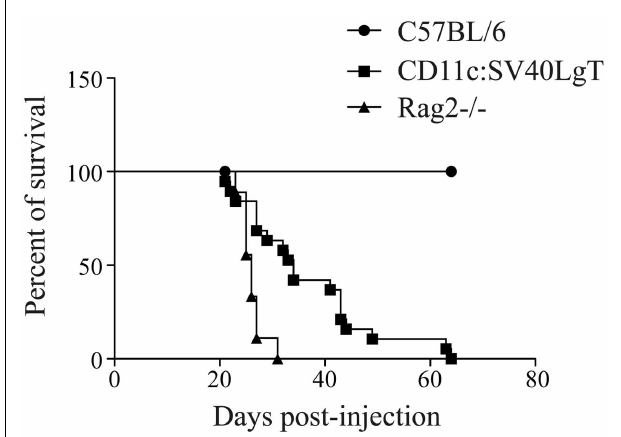
FIGURE 1 | MuTu tumors developed in tolerant CD11c:SV40LgT and Rag-deficient mice but not in immunocompetent C57BL/6 mice . Five × 10 6 MuTuDC lines were transferred by iv route into C57BL/6 ( n = 19), CD11c:SV40LgT ( n = 19), or Rag2 − / − mice ( n = 9).The percent of survival was displayed according to the day